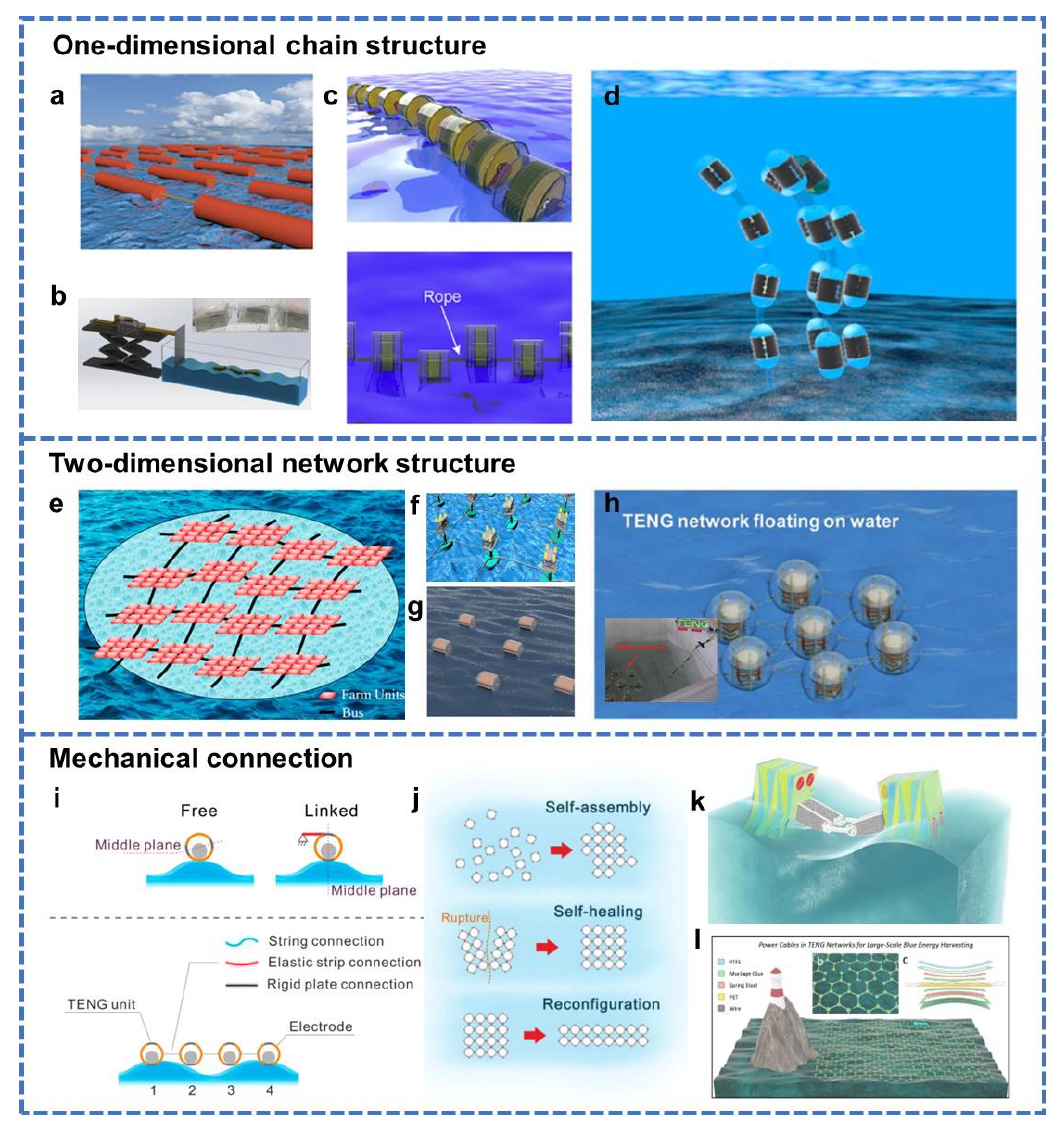
Figure 3. ( a ) Sea snake composed of TENG units. ( b ) Diagram of the TENG device floating on the water surface. ( a , b ) Reprinted with permission from ref. [51], Copyright 2022, Elsevier. ( c ) Structure of the tandem disk TENG device. Reprinted with permission from ref. [53], Copyright 2019, Elsevier. ( d ) Network connecting TENG units vertically to the bottom of the ocean. Reprinted with permission from ref. [39], Copyright 2019, American Chemical Society. ( e ) Configuration of the quadrilateral network with the multilayered connection. Reprinted with permission from ref. [54], Copyright 2015, American Chemical Society. ( f ) Square network of the buoy-based TENG device. Reprinted with permission from ref. [42], Copyright 2021, Elsevier. ( g ) Schematic diagram of the network composed of the soft-contact cylindrical TENG devices. Reprinted with permission from ref. [61], Copyright 2021, Wiley. ( h ) Hexagonal network containing seven TENG units. Reprinted with permission from ref. [56], Copyright 2019, Wiley. ( i ) Three types of connections: rigid plate connection, elastic strip connection, and string connection. Reprinted with permission from ref. [57], Copyright 2018, American Chemical Society. ( j ) Self-assembly TENG network with rational self-adaptive magnetic joints. Reprinted with permission from ref. [58], Copyright 2019, Elsevier. ( k ) Hybrid harvester designed by the pivot hinge. Reprinted with permission from ref. [59], Copyright 2019, Wiley. ( l ) TENG network based on the plane-like power cables. Reprinted with permission from ref. [60], Copyright 2020, the authors.